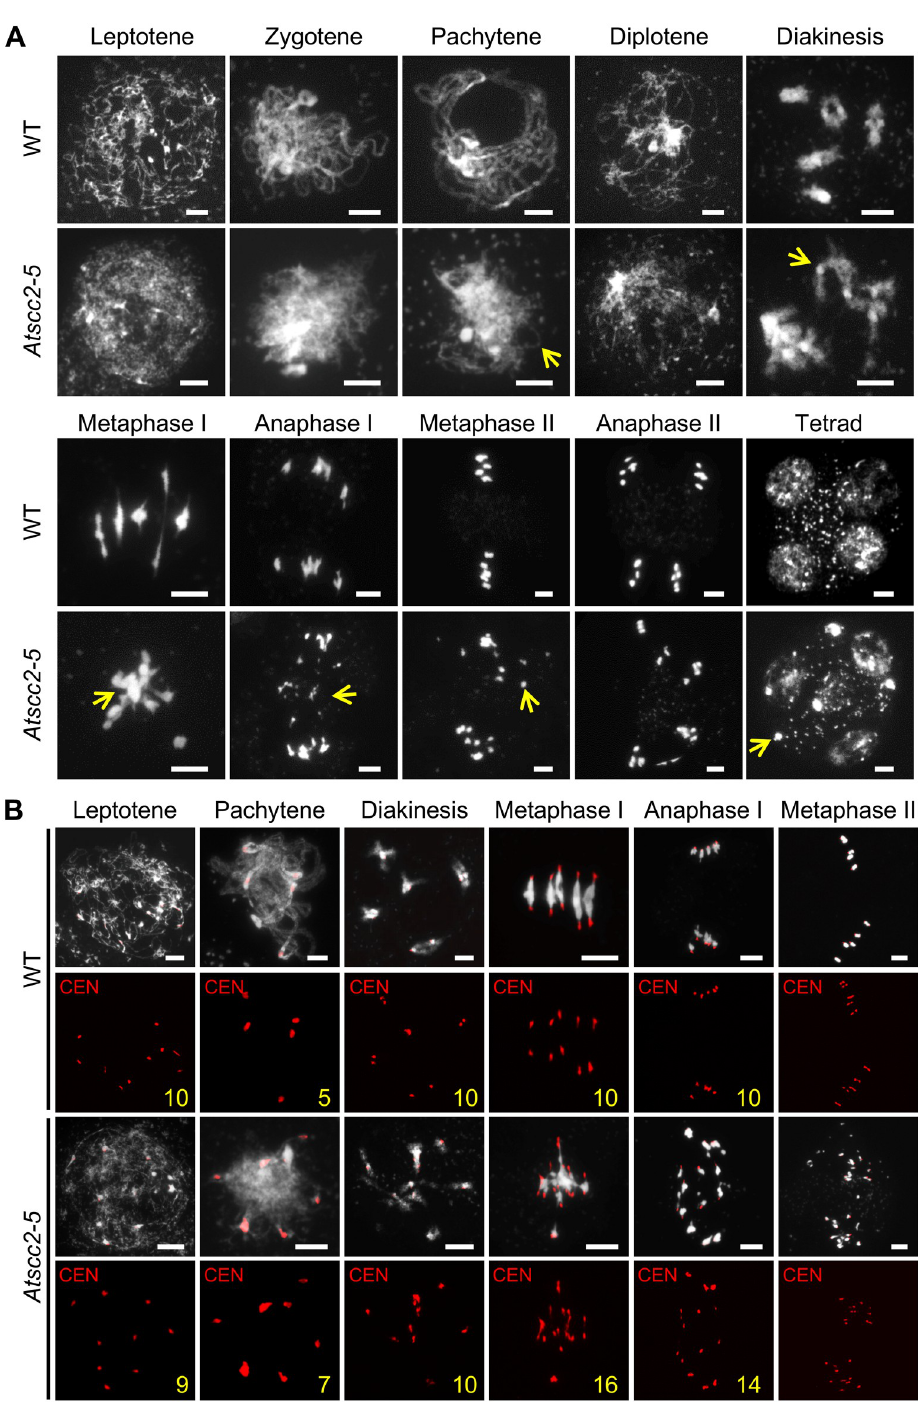
Fig 2. Chromosome morphology of Atscc2-5 and WT male meiocytes. (A) Chromosome spreads of WT and Atscc2- 5 male meiocytes stained by DAPI. Yellow arrows indicate the asynaptic chromosomes, univalent, abnormal chromosomal entanglements or fragments in Atscc2-5 . Bar = 5 μ m. (B) Fluorescence in situ hybridization (FISH) of WT and Atscc2-5 chromosomes using a centromere probe. Yellow numbers indicate the number of centromeres in the meiocytes. Bar = 5 μ m.